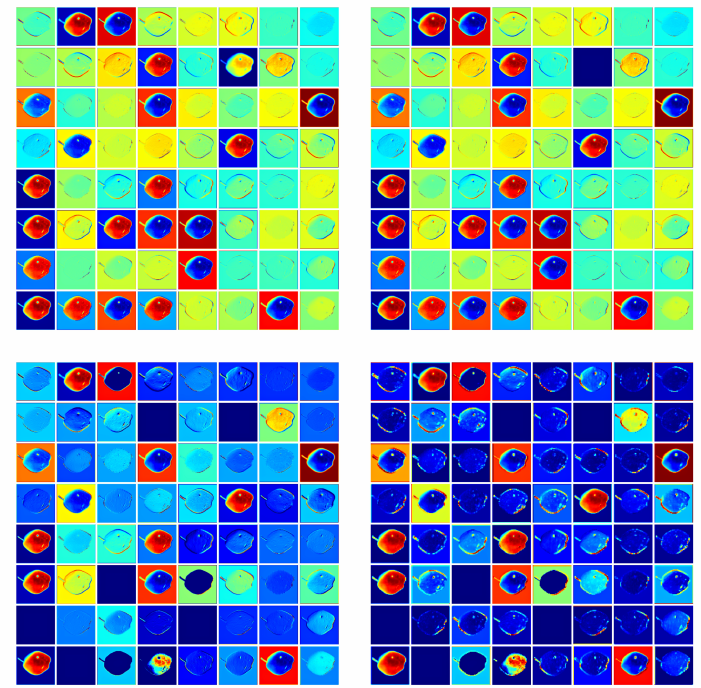
Figure 12. Visualization of shallow feature